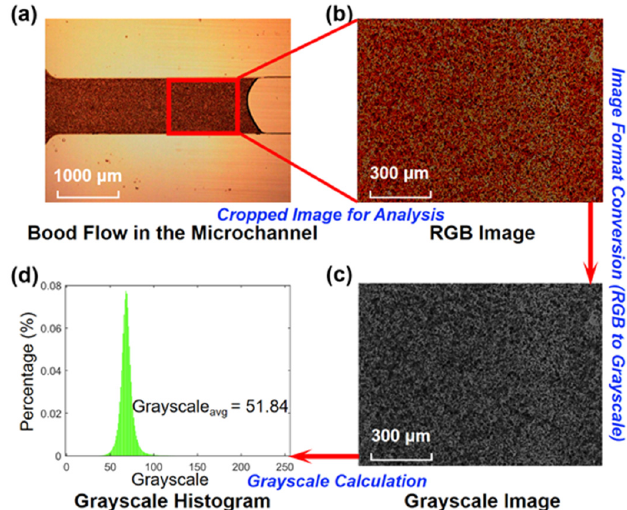
Figure 4. Schematic representation of the grayscale measurement to quantify the hematocrit during blood flow in the microchannel: ( a ) the frame captured from the video of the blood flow in the microchannel (with 1000 µm width and 100 µm depth); ( b ) cropped image from Figure 4a in RGB format; ( c ) converted grayscale image from Figure 4b; ( d ) the plot of the grayscale histogram with average grayscale of